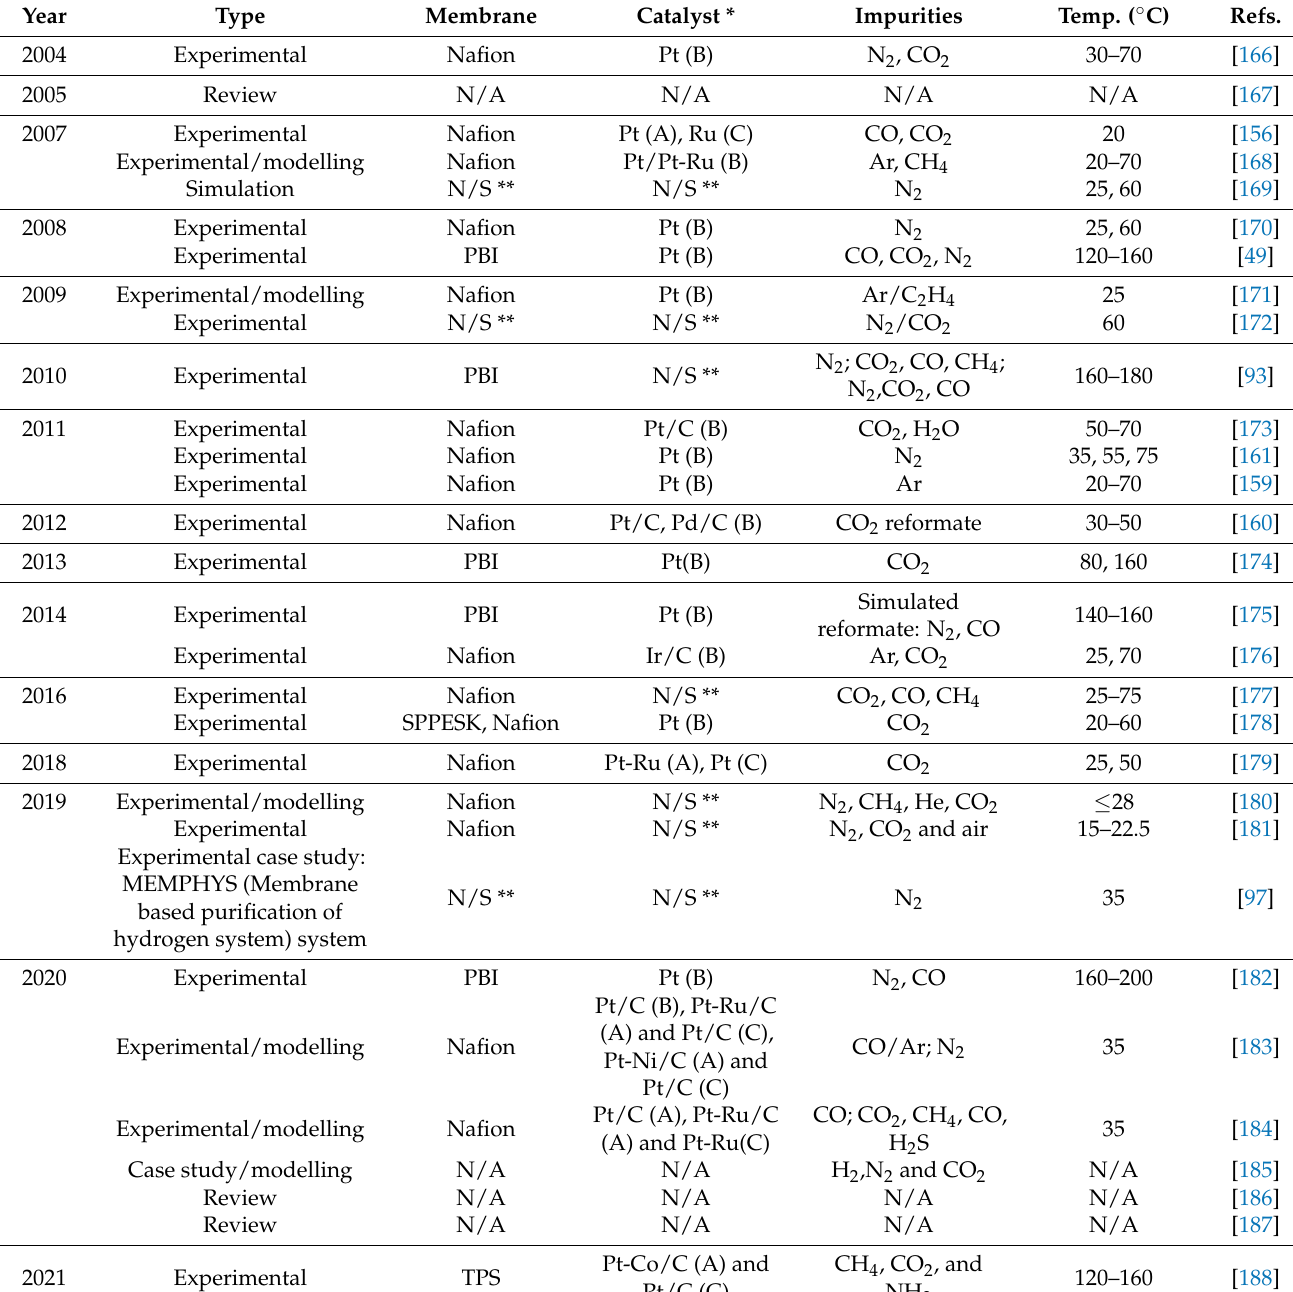
Table 4. Summary of published articles on electrochemical hydrogen